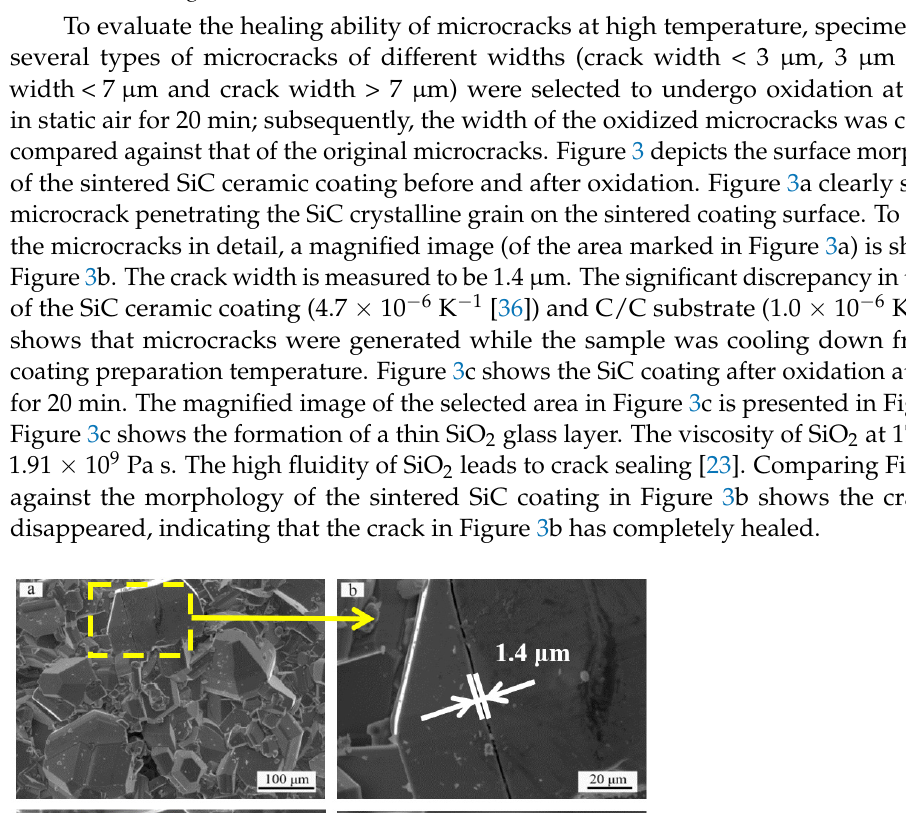
Figure 4. Surface morphologies of the SiC coating: ( a ) original surface before oxidation, ( b ) magni- fied image of the selected area in ( a ) showing a typical crack with 5.3 μ m in width, ( c ) top view of the same area in ( a ) after oxidation for 20 min, ( d ) magnified image of the selected area in ( c ) show- ing the healing of the crack, ( e ) top view of the same area in ( a ) after oxidation for 40 min, ( f ) mag- nified image of the selected area in ( e ) showing the healing of the crack.